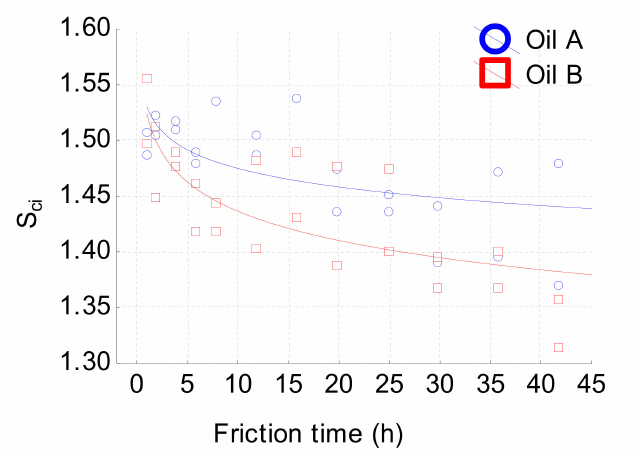
Figure 12. S ci evolution versus friction time obtained by a high pass filter with a cuto ff of 100 µ